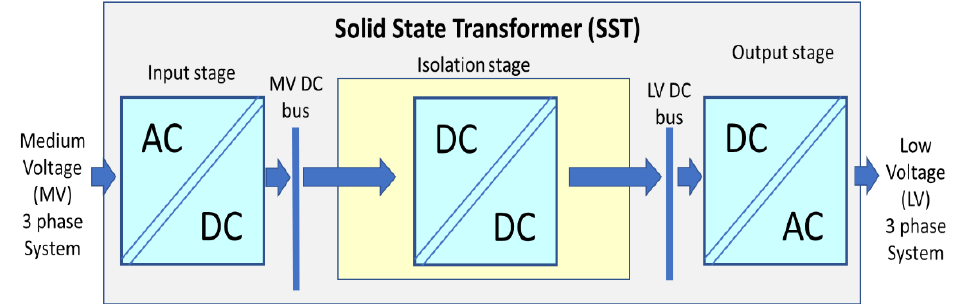
Figure 1. Solid state transformer design example.